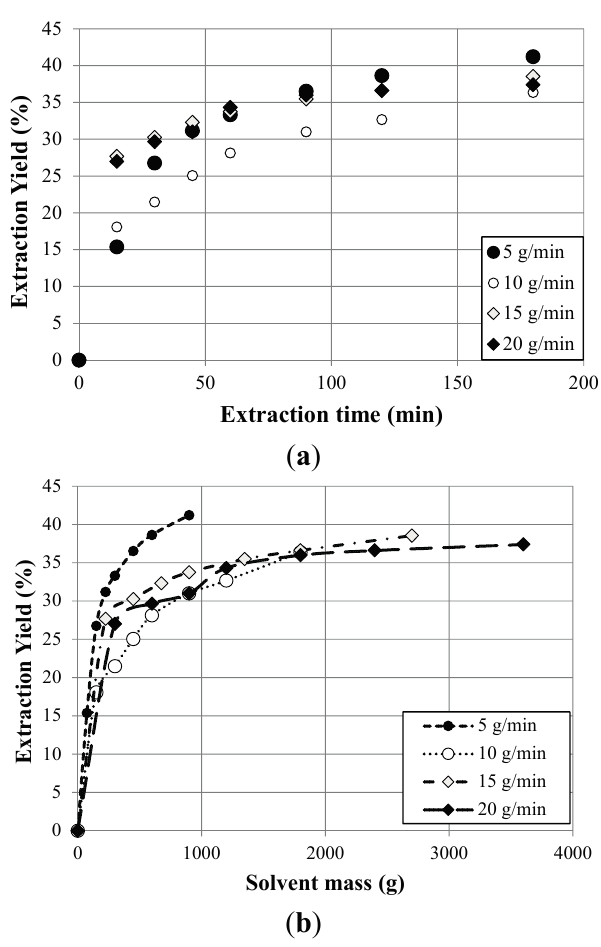
Figure 6. Kinetic extraction in terms of extractions time ( a ) and solvent mass ( b ) for PLE from Petit Verdot grape pomace at 90 bar of pressure and 120 °C of temperature with ethanol/water (50:50) at different flow